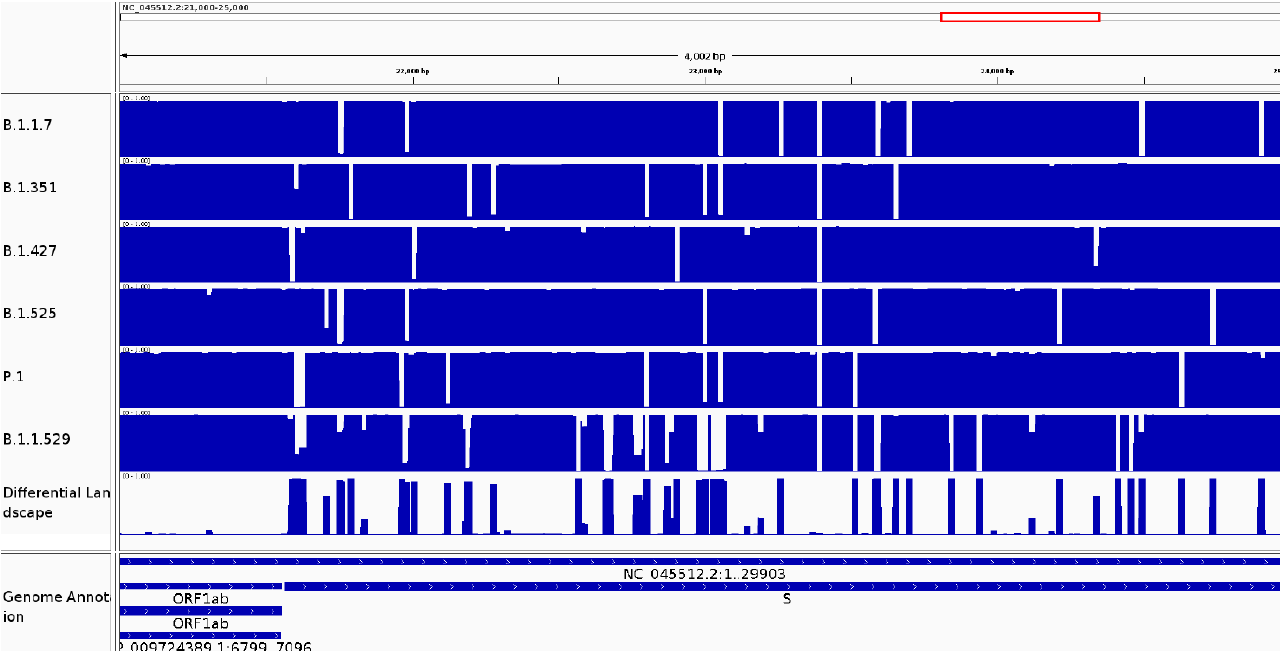
Figure 5. Conservation and differential landscapes for SARS-CoV-2 variants. The visualization gen- erated by CovDif via IGV for the genomic interval 21,000–25,000 is shown. Top tracks: conservation landscape for each SARS-CoV-2 variant; middle track: differential landscape showing the biggest difference between all groups; and bottom track: SARS-CoV-2 annotation .